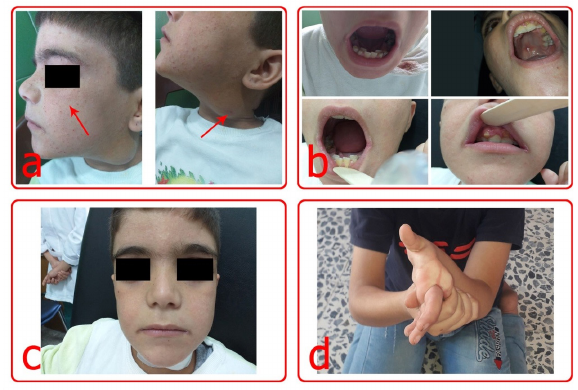
Figure 1. Job`s Syndrome Features. Note . (a) Pruritic eczematous dermatitis on the face and the cold neck mass was anterior to the left sternocleidomastoid muscle (2 nd and 3 rd neck levels), measured approximately (3×4) cm. (b) Oral manifestations included retained primary teeth, double rows of teeth with both primary and constant intermixed teeth, a high arched palate, erythematous mucosa, and caries. (c) Course facies with a prominent forehead, broad nasal bridge, deep-set eyes, and protruding pores. (d) Joint hyper- extensibility.